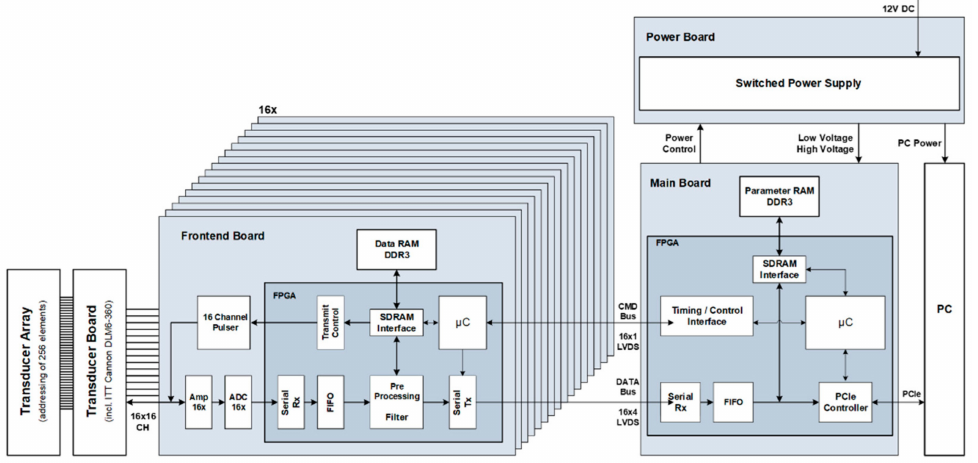
Figure 2. System architecture of a single 256-channel